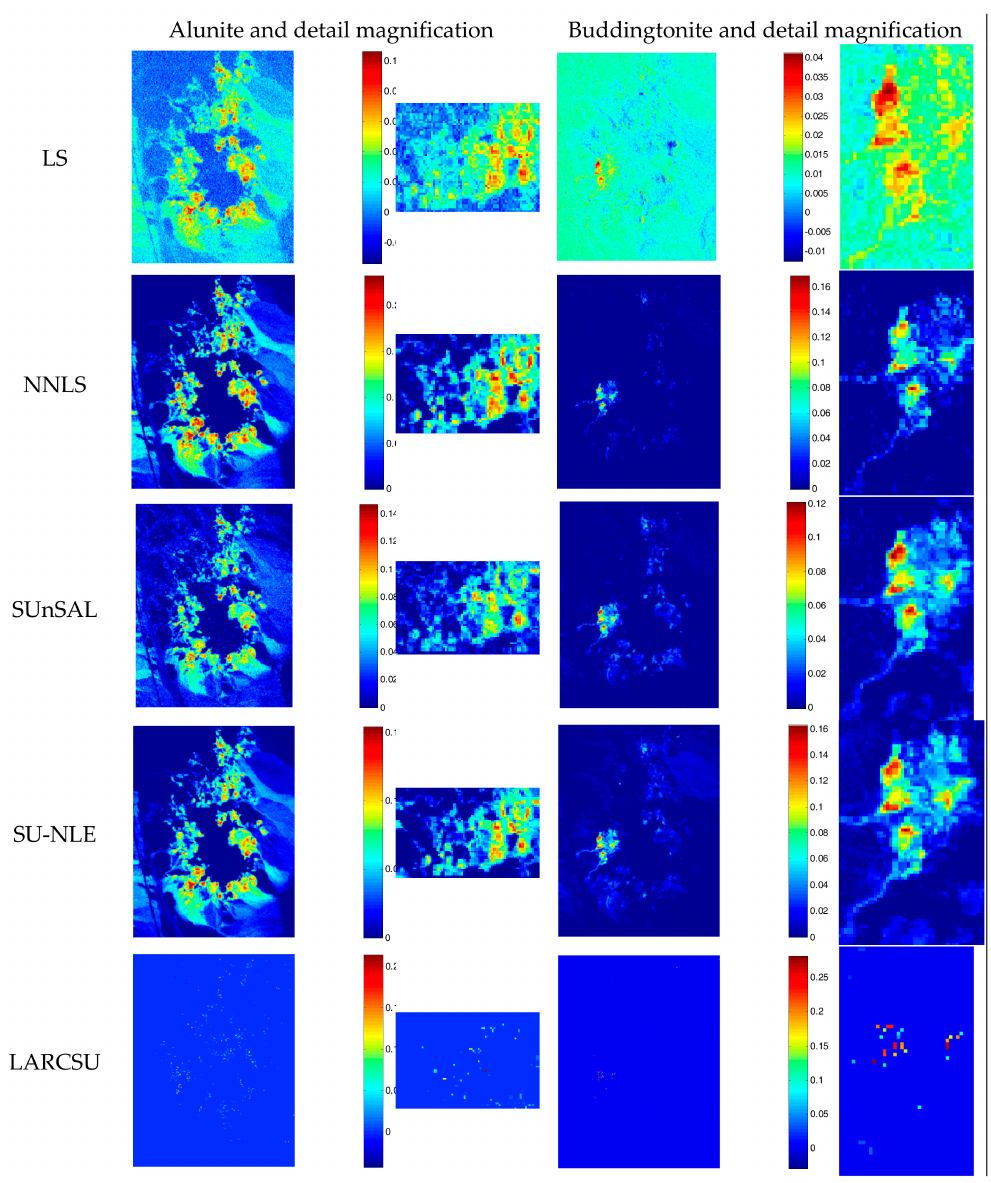
Figure 10. Estimated abundances of alunite and buddingtonite for the Cuprite